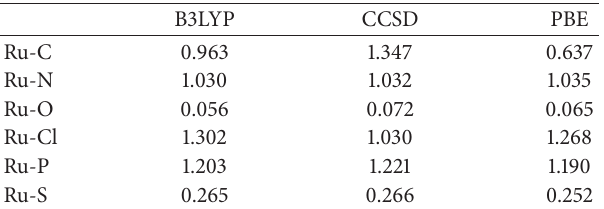
Table 3: The correlation of the values of energy and thermody- namics properties at MP2/SBKJC VDZ with other computational methods.